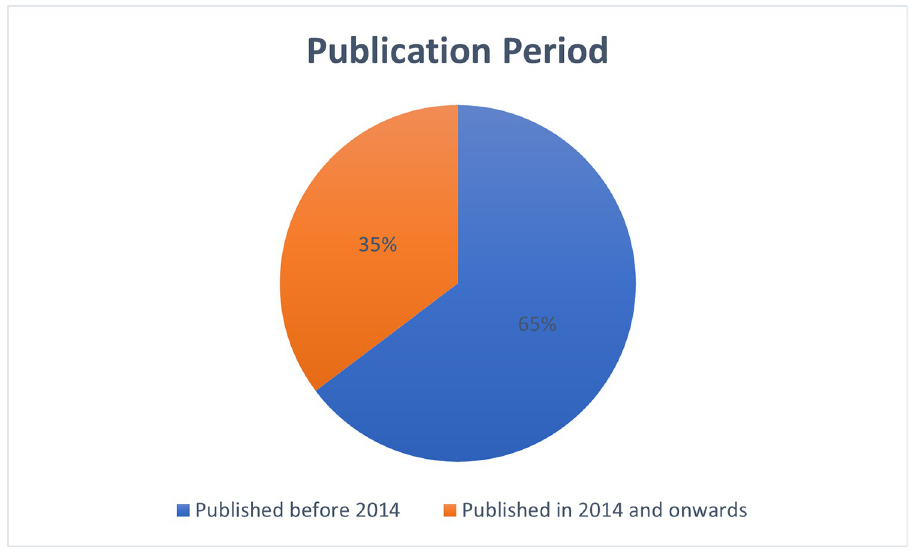
Fig 3. Analysis based on publication period.